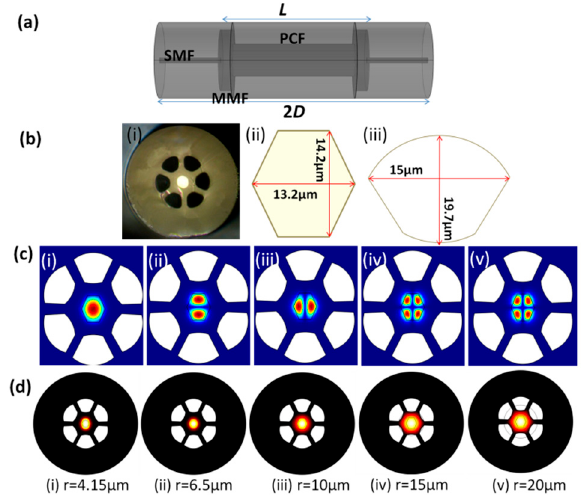
Figure 1. ( a ) Schematic of the proposed MZI structure; ( b ) (i) The optical micrograph of the PCF’s cross section, (ii) The dimension of the core, and (iii) the dimension of the air hole; ( c ) The simulated mode field distributions in the core of PCF at 1550 nm: (i) LP 01 mode, (ii) and (iii) LP 11 modes, (iv) and (v) LP 21 mode; ( d ) The effect of LP 01 input beam radius, r , on the mode profile in the PCF.